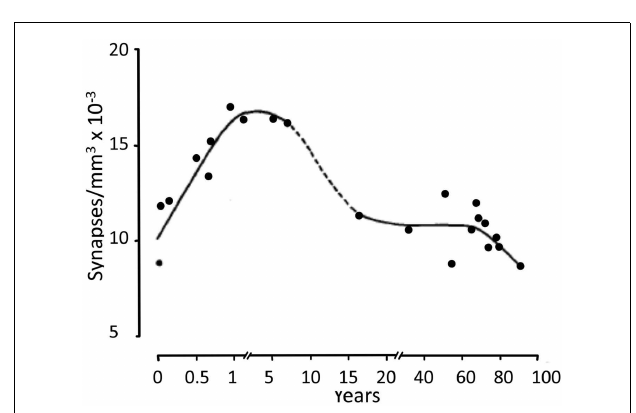
FIGURE 11 | Developmental changes in synaptic density in frontal gyrus, peaking at 12–15months of age, and before or during adolescence decreasing to similar levels as in the newborn . From Huttenlocher